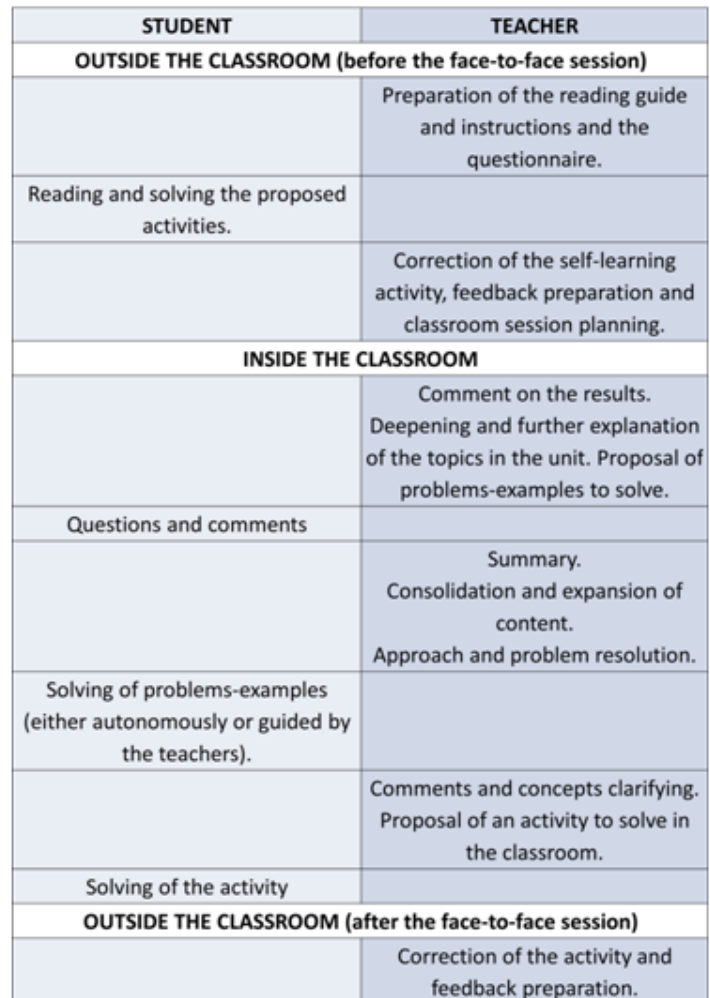
Figure 6. Methodological